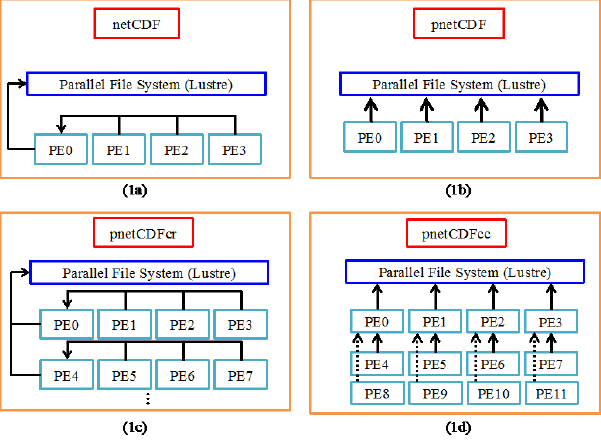
Figure 1. Conceptual diagrams of four I/O modules: serial I/O used in current CMAQ with netCDF data format (a) , straight pnetCDF implementation (b) , with data aggregation along row dimension and then use of pnetCDF (c) , and with data aggregation along column dimension and then use of pnetCDF (d) . PE denotes a processor. Arrows show the direction of data